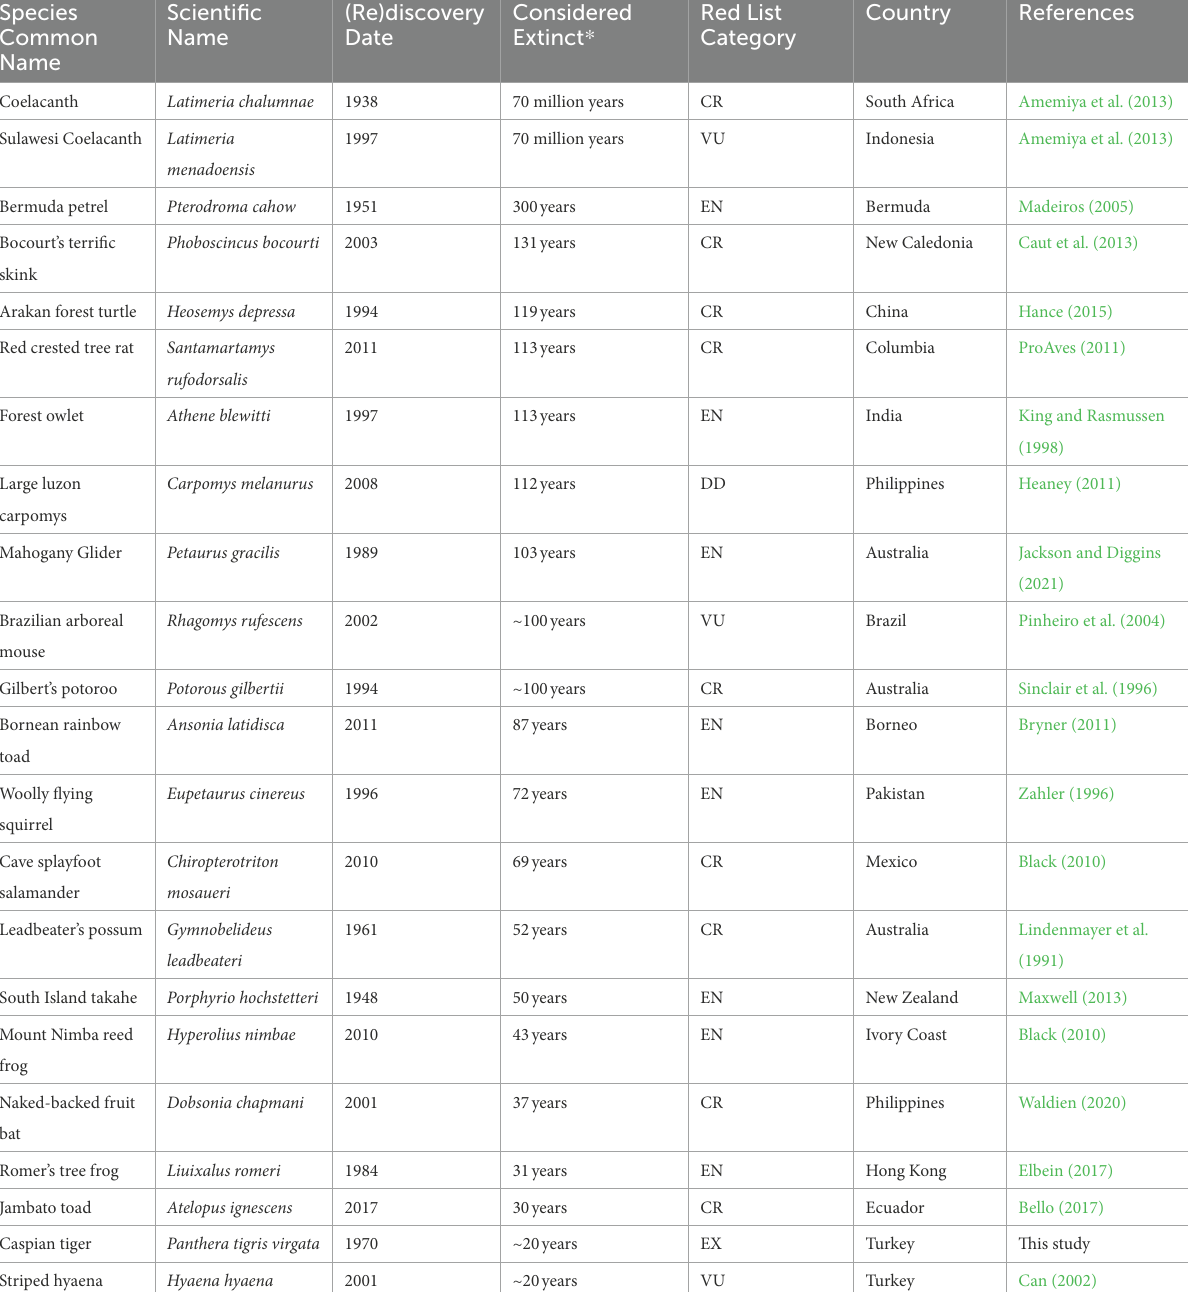
TABLE 1 A selection of species from the literature which were prematurely considered extinct resulting in missed conservation